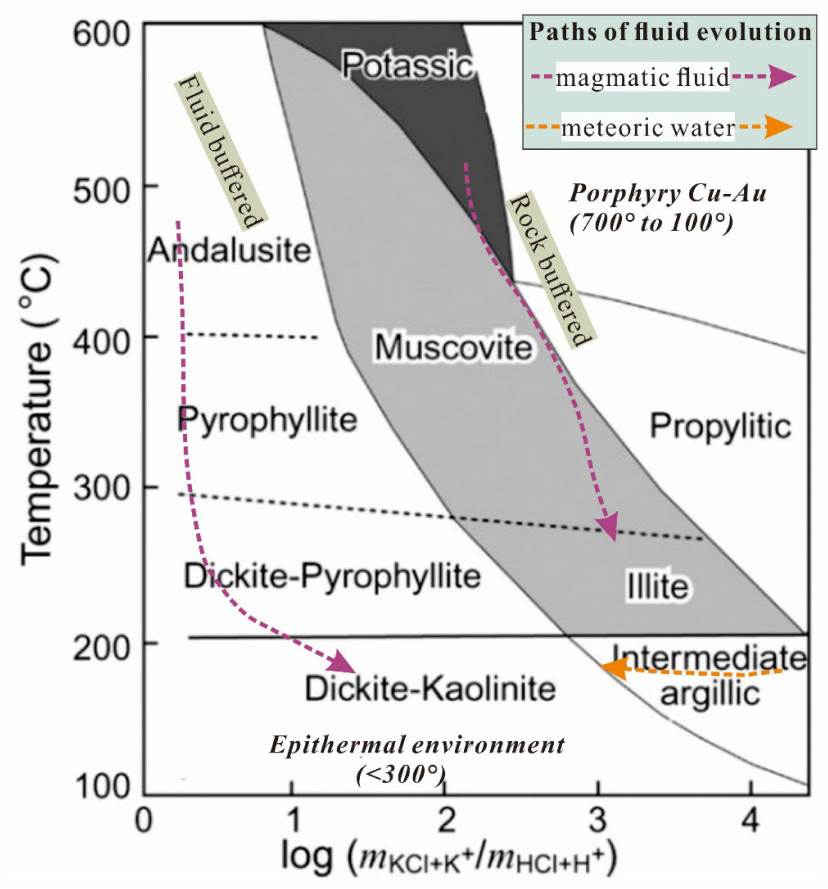
Figure 7. Phase diagram showing the alteration zones and their controlling factors in porphyry Cu-Au system and epithermal system (Modified from [84]). The phase boundaries are schematically constrained. The path of magmatic fluid on the left represents a fluid-dominant alteration sequence, whereas the one on the right illustrates rock-buffered alterations. A late influx of meteoric water into the porphyry environment forms the widespread rock-buffered intermediate argillic